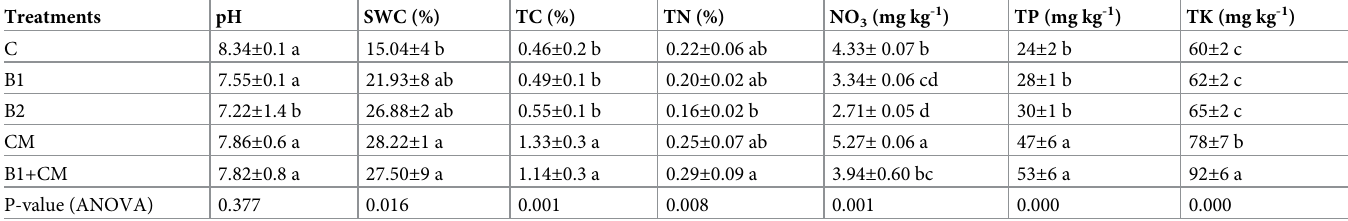
Table 2. Biochar and compost effect on soil properties.